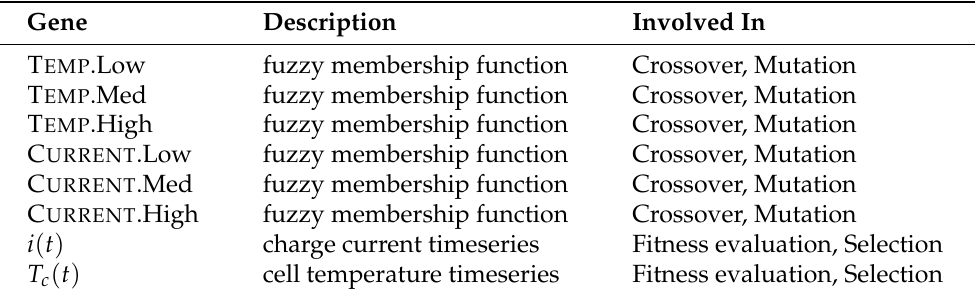
Table 3. Structure of the chromosome. Gene